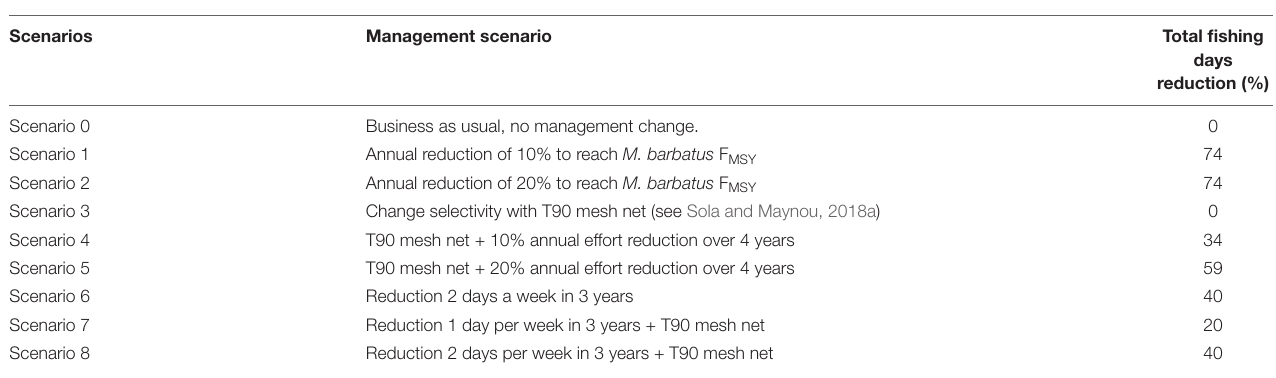
TABLE 2 | Management scenarios considered in the bioeconomic model for demersal fisheries in GSA 06.